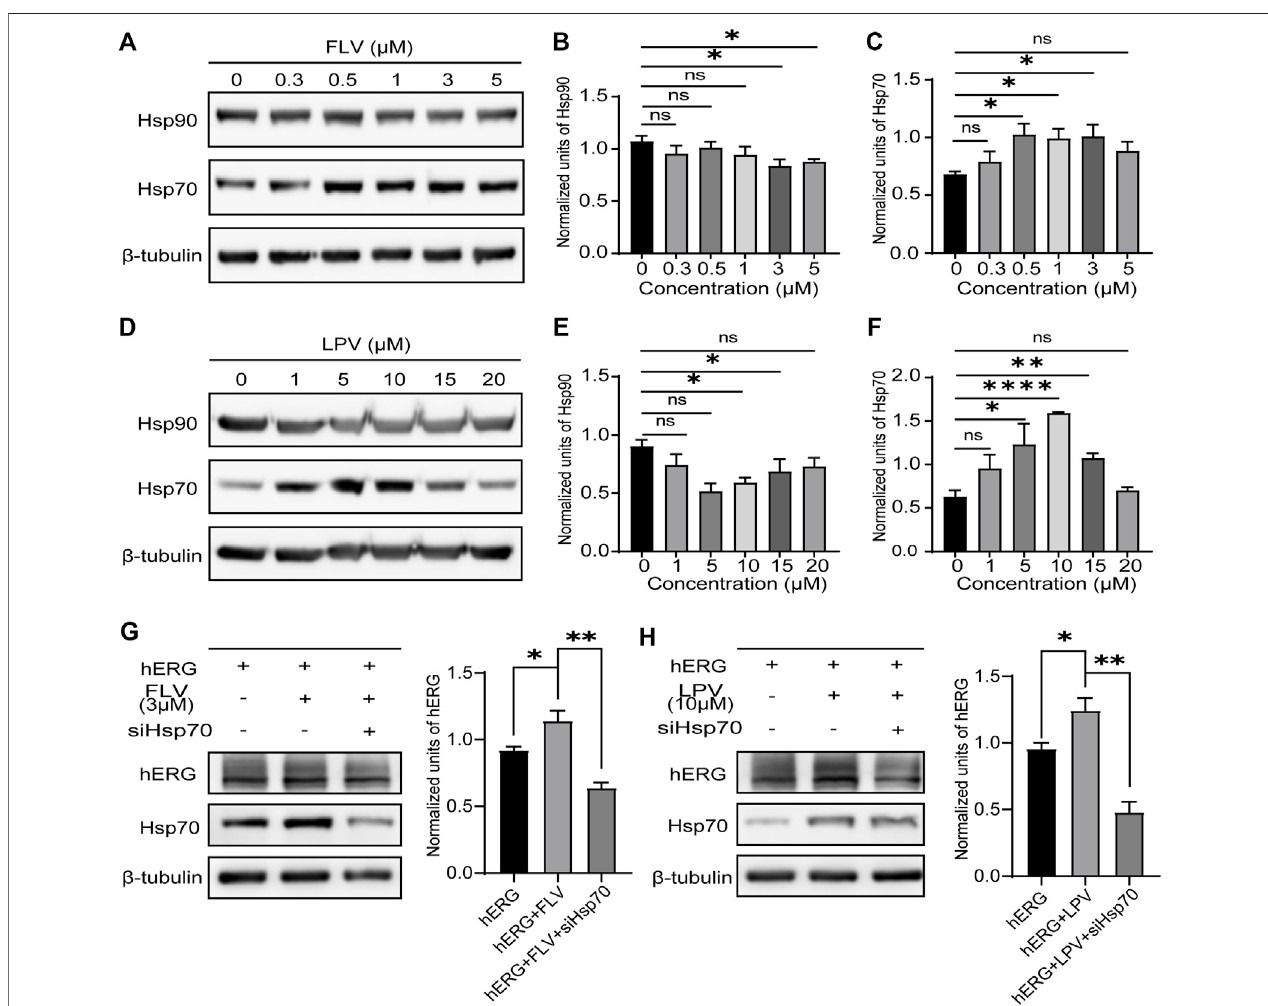
FIGURE5| Reduced expressionofHsp70reversestheroleofFLVandLPVinpromotinghERGmaturation. (A) WesternblotofcriticalhERGtraf fi ckingchaperone Hsp90 and Hsp70 in control (0 μ M) and 24 h incubation with FLV from 0.3 to 5 μ M, along with internal control β -tubulin. (B,C) Densitometric evaluations of Hsp90 and Hsp70normalizedwith β -tubulinundereachdrugconcentration,respectively.* p < 0.05.ns,non-signi fi cant. (D) WesternblotofHsp90andHsp70proteinincontroland FLV from 1 to 20 μ M, along with internal control β -tubulin. (E,F) Densitometric evaluations of normalized Hsp90 and Hsp70. (G) Immunoblotting and band density statistics for hERG, Hsp70, and the internal reference β -tubulin before (hERG) and after 24 h incubation of FLV with (hERG + FLV + siHSP70) and without (hERG + FLV) thereducedexpressionofHsp70usingsiRNA. (H) Immunoblottingandbanddensitystatistics forhERG,Hsp70,andtheinternalreference β -tubulin inthehERG,hERG + LPV, and hERG + LPV + siHSP70 groups. * p < 0.05, ** p < 0.01, and **** p < 0.0001. ns, non-signi fi cant.